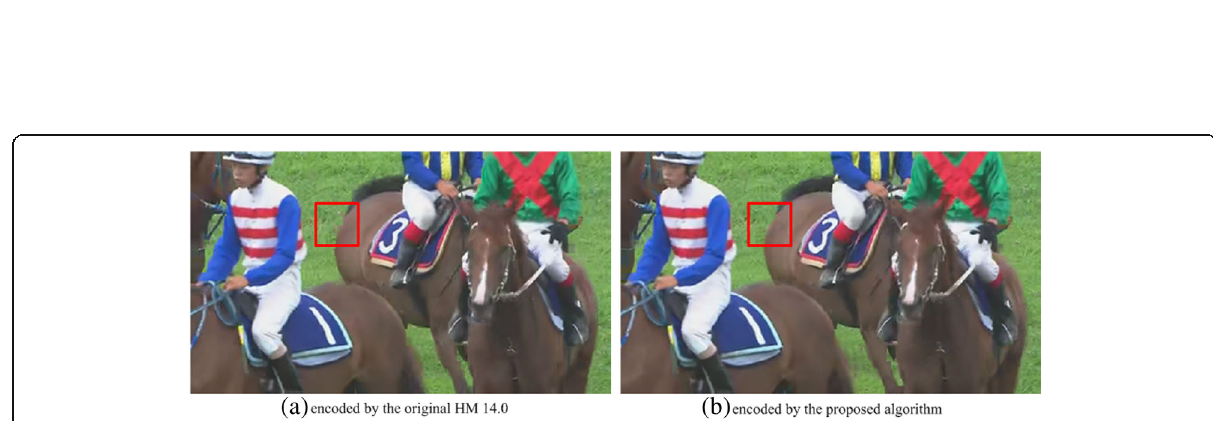
Fig. 8 Comparison of the subjective quality of the 22nd frame in “ RaceHorses ” . a Encoded by the original HM 14.0. b Encoded by the proposed algorithm